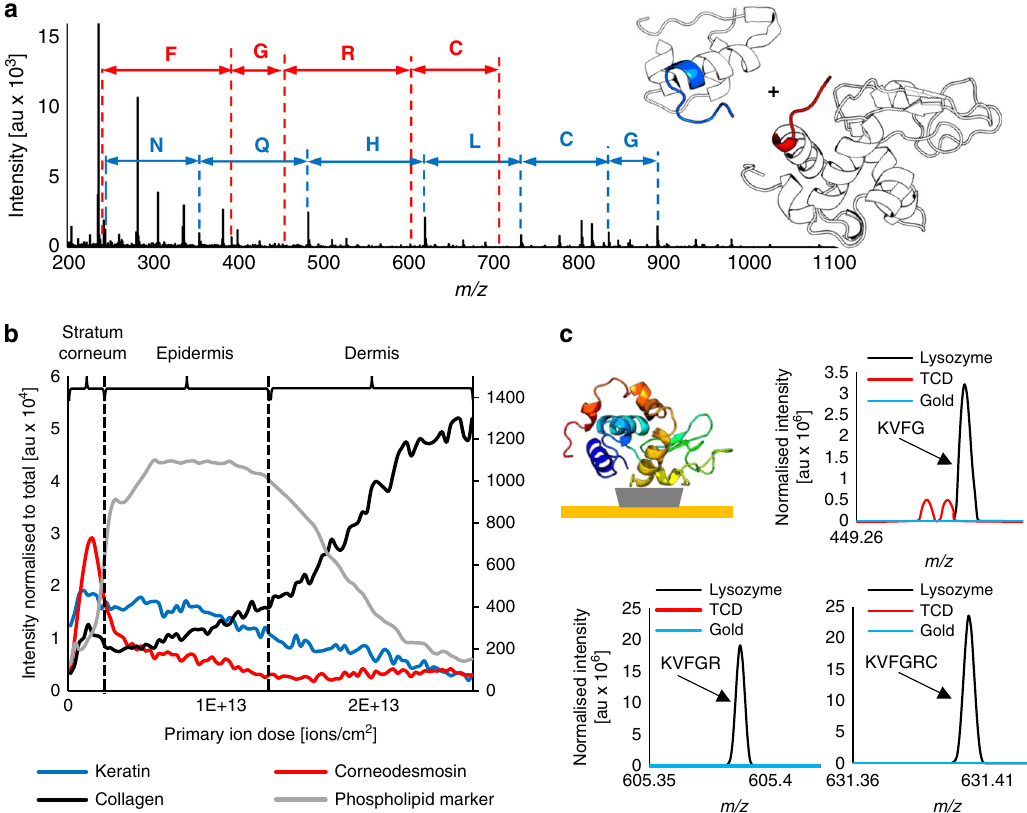
Fig. 2 The applications of the ballistic sequencing in surface analysis. a Sequences of lysozyme (red) and insulin (blue) were simultaneously detected, allowing imaging of a protein mixture. The identi fi ed sequences are highlighted in insulin and lysozyme structures, exported from PDB entries 3I40 37 and 1AZF 38 , respectively. b Three proteins were pro fi led in situ in a human skin sample. The dashed lines indicate borders between the skin layers, assigned based on the pro fi le of phospholipid marker (PO 3 − ). PO 3 − is presented on a secondary scale for clarity due to high intensity throughout the pro fi le. Example peaks of keratin ( stratum corneum and epidermis, blue), corneodesmosin ( stratum corneum , red), and collagen (dermis, black). ( c ) Characteristic lysozyme fragments representing the KVFGRC sequence were detected in a protein biochip, consisting of a protein monolayer immobilized on heptakis-(6-deoxy-6-thio)- β -cyclodextrin